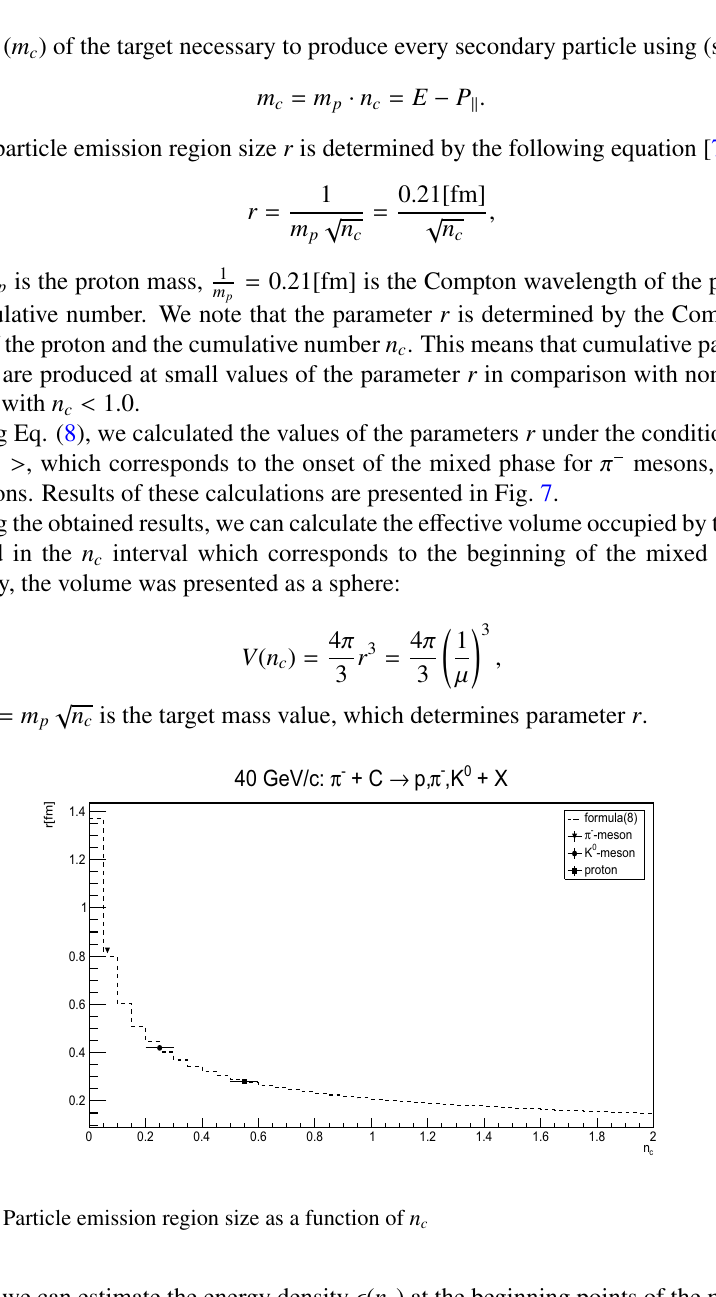
= m · < n > for π − mesons, K (8)-(10) at m i p c 2 40 GeV / c are shown in